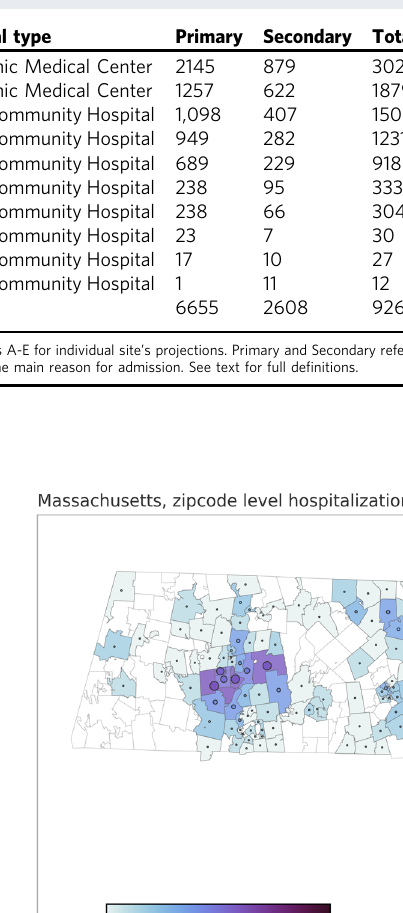
Table 1 Total number of COVID-19 hospitalizations across the hospitals in our network of study between March 7, 2020 and April 12,